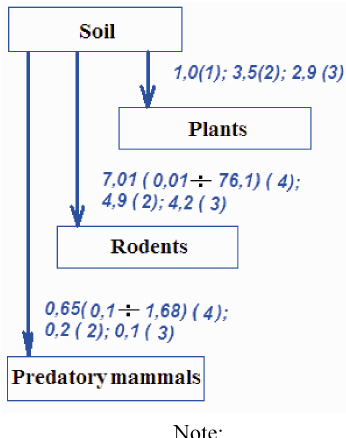
137 Fig. 15. Values of Cs accumulation coefficients in fox trophic chain: 1– Радиоэкология... 1977; 2 – Resrad biota 2004; 3 – research determined; 4 – EPIC...